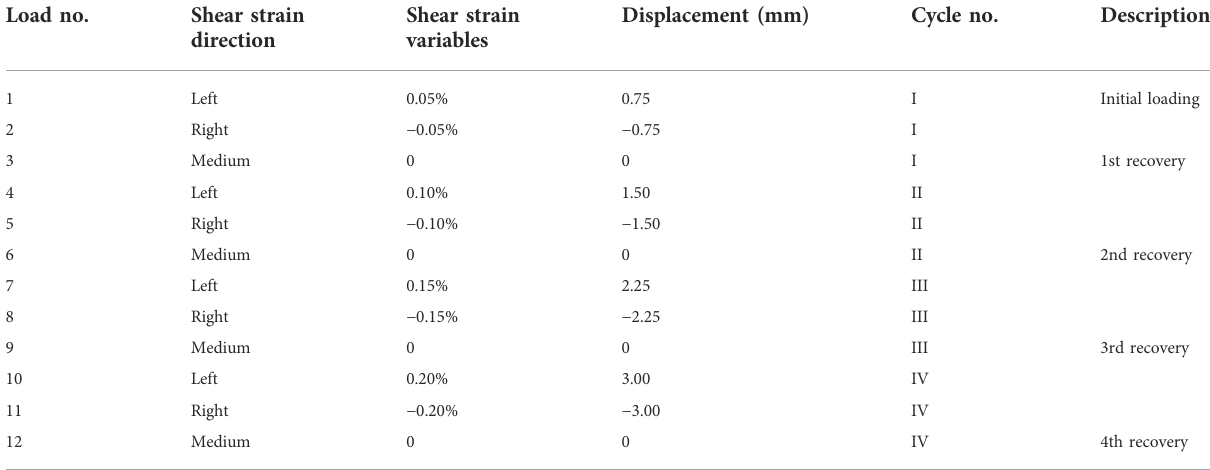
TABLE 5 Loading